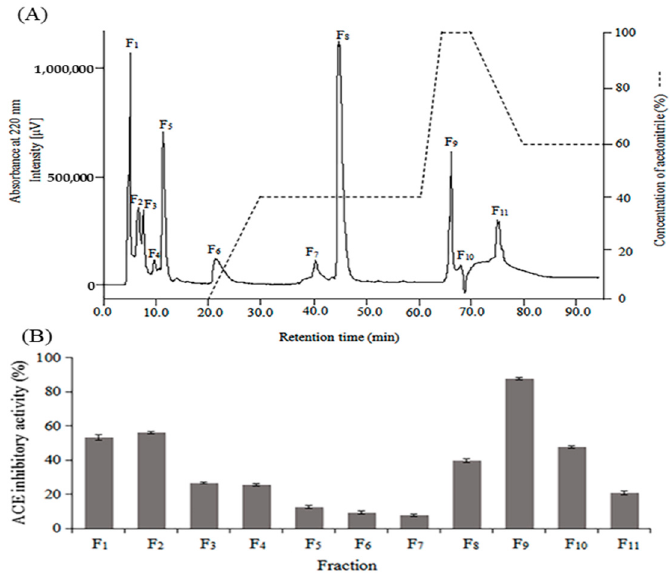
Figure 2. Purification profile of KSHPH separated by RP-HPLC using a TSKgel ODS-80TM column ( A ). Protein hydrolysate was eluted by a linear gradient of acetonitrile (0~20 min, 100% A; 20~30 min, 100% A → 60% A/40% B; 30~60 min, 60% A/40% B; 60~65 min, 60% A/40% B → 100% B; 65~70 min, 100% B; 70~80 min, 100% B → 40% A/60% B) at a flow rate of 1.0 mL/min. ACE inhibitory activity of each fraction (F 1 –F 11 ) was measured at a concentration of 8 mg/mL ( B ).